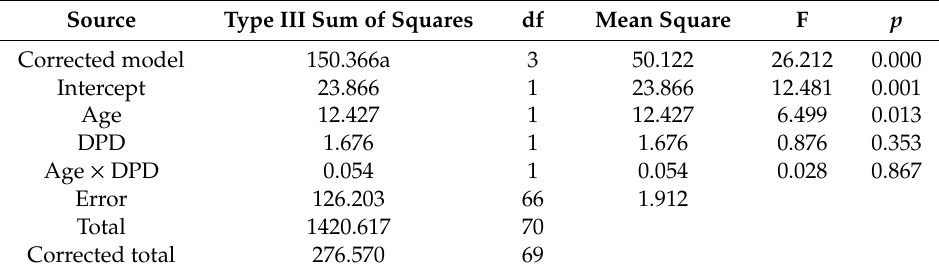
Table 5. Multiple regression analysis with interaction term (adjusted R 2 = 0.523).